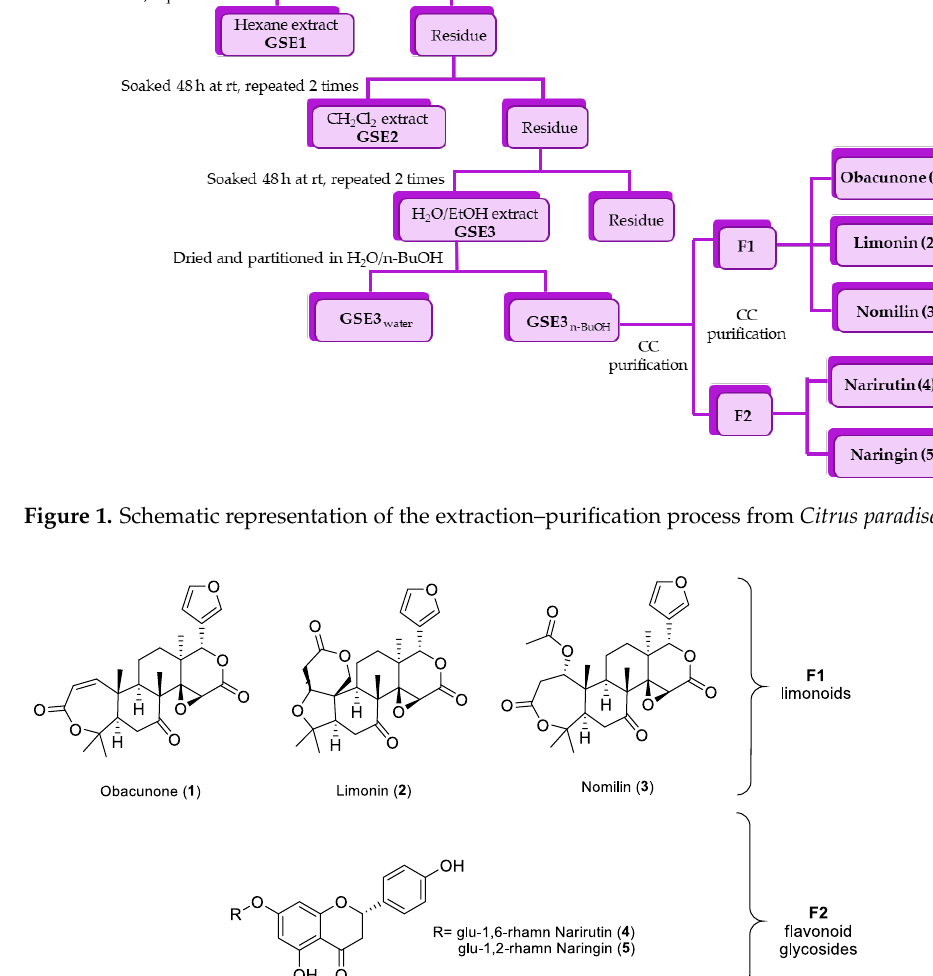
Figure 2. Structures of purified limonoids and flavonoid glycosides . Fraction F1 : obacunone ( 1 ), limonin ( 2 ) and nomilin ( 3 ); fraction F2 : narirutin ( 4 ) naringin ( 5 ).